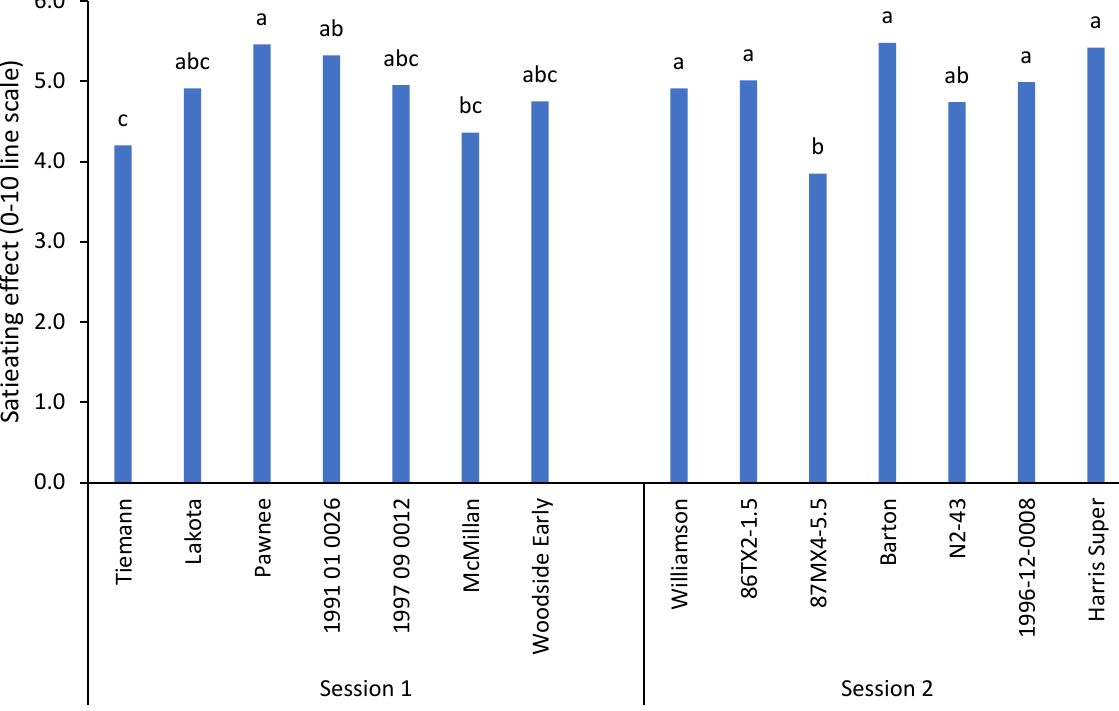
Figure 3. Consumer mean scores ( n = 99) for energizing effects of 14 pecan samples on a 0–10 line scale. Different letters ( a , b ) within attributes indicate significant differences between samples ac- cording to one-way ANOVA and Tukey’s HSD test. In addition, participants were asked to show their emotional responses to the pecan kernels. As shown in Table 3, the most frequently checked terms for the pecan samples